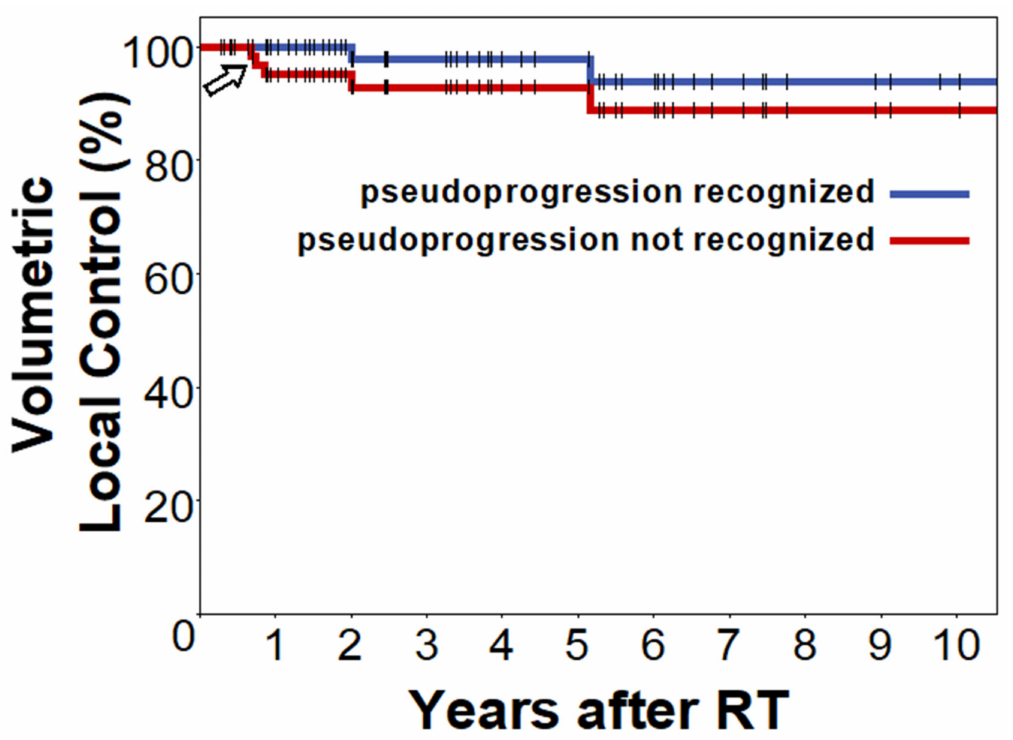
Figure 3. Apparent volumetric local control, if the study would have been a prospective trial and pseudoprogression was accounted for (blue) and was not accounted for (red). Kaplan–Meier plots with vertical bars indicating censored cases. In the red plot, surpassing the volumetric threshold for progression was counted as an event (step in Kaplan–Meier plot) irrespective of further follow- up. In the blue plot, surpassing the threshold for volumetric progression was not counted as an event, if followed by spontaneous volumetric regression ≥ 20% relative to maximum tumor volume (=pseudoprogression). In the case of a prospective trial, this corresponds to continuing imaging follow-up beyond surpassing the threshold for volumetric progression and incorporating pseudoprogression/transient enlargement in the response assessment criteria. Note: additional progression events in the first year after RT, if transient enlargement/pseudoprogression was not recognized (steps in Kaplan–Meier plot,